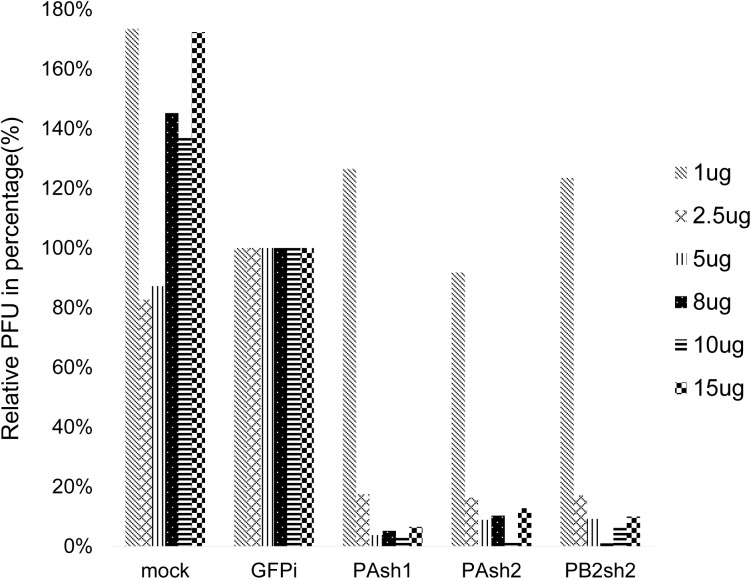
Dose-dependent inhibitory ability of shRNA plasmids against influenza A/WSN/33 virus in Vero cells.Vero cells were pretreated with shRNA, which was followed by infection with influenza A/WSN/33 virus at 48 hours. Cell supernatants were harvested at 24 hours post-infection and subjected to a plaque reduction assay to determine the viral titers. Compared with the green fluorescent protein (GFP) vector control group, PAsh1, PAsh2, and PB2sh2 significantly inhibited virus replication in a dose-dependent pattern and reached a maximal inhibitory effect at 8–10 μg, which depended on the shRNA that was used.